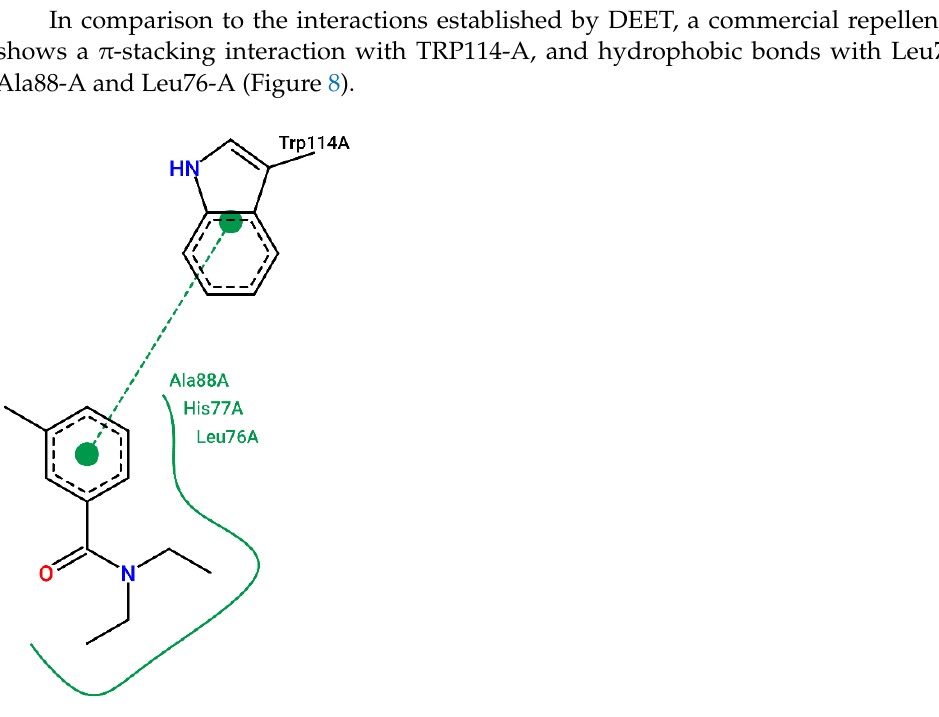
Figure 7. ( A ) Interaction map of ZINC305 in the PoseView software generated by the Aaeg OBP1 binding site (ChemPLP = 42.71). ( B ) ZINC305 superimposed on the model pharmacophore Aaeg OBP1 (QFIT = 85.41). Cyan spheres represent hydrophobic centers (HY) and green spheres represent hydrogen bond donors (HBD). The size of the spheres varies according to the radius tolerance calculated by GALAHAD™. All distances were measured in angstroms. (Legend: Ligand: Carbons are represented in green, nitrogen in blue and oxygen in red).